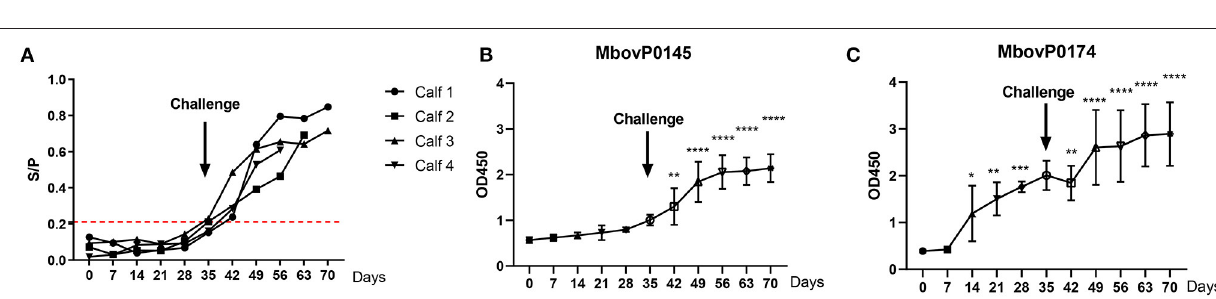
FIGURE 8 | Kinetics of the serum antibody response to a post-immunization Mycoplasma bovis challenge. Four calves were immunized with attenuated M. bovis P150 for 35 days and then challenged with the wild M. bovis P1, followed by observation for a further 35 days. (A) The rMbovP0145-iELISA as the S/P value was used for the kinetic detection of M. bovis -positive in serum. The cutoff value is set at 0.211 as red dotted lines. (B,C) Comparison of the serum antibody response, expressed as OD 450 values, induced by MbovP0145 and MbovP0174. Data represent means ± SD. Significant differences in the response vs. 0 days were identified using a one-way ANOVA test. * p < 0.05, ** p < 0.01, *** p < 0.001, **** p <